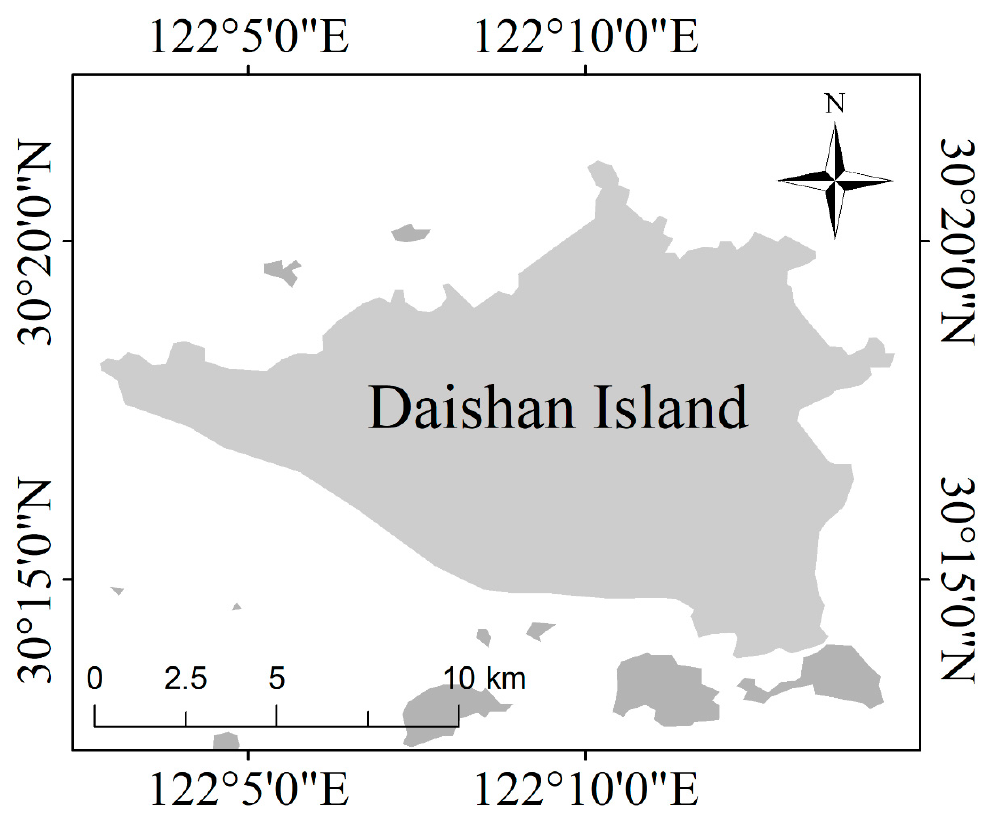
Figure 8. Location of Daishan Island, China.